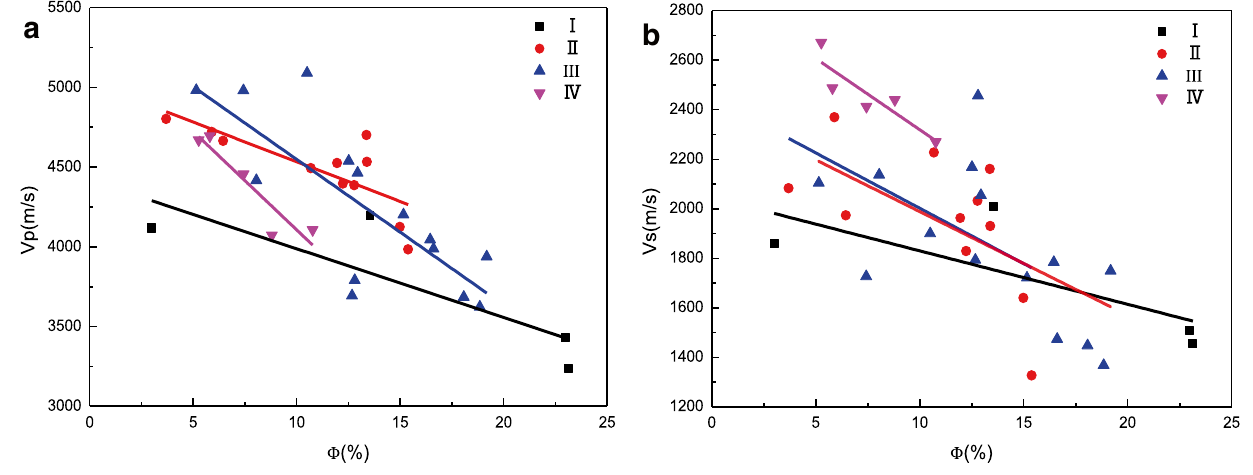
Fig. 4 a Crossplot of V Φ in different pore structure sandstones; b crossplot of V p and